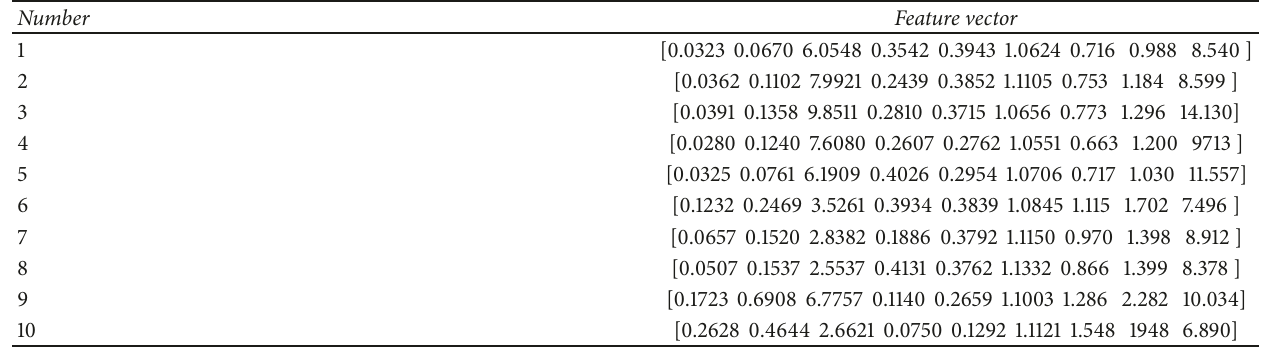
Table 3: The feature vector of corn’s multiwavelet entropy of the moderate drought stress group.